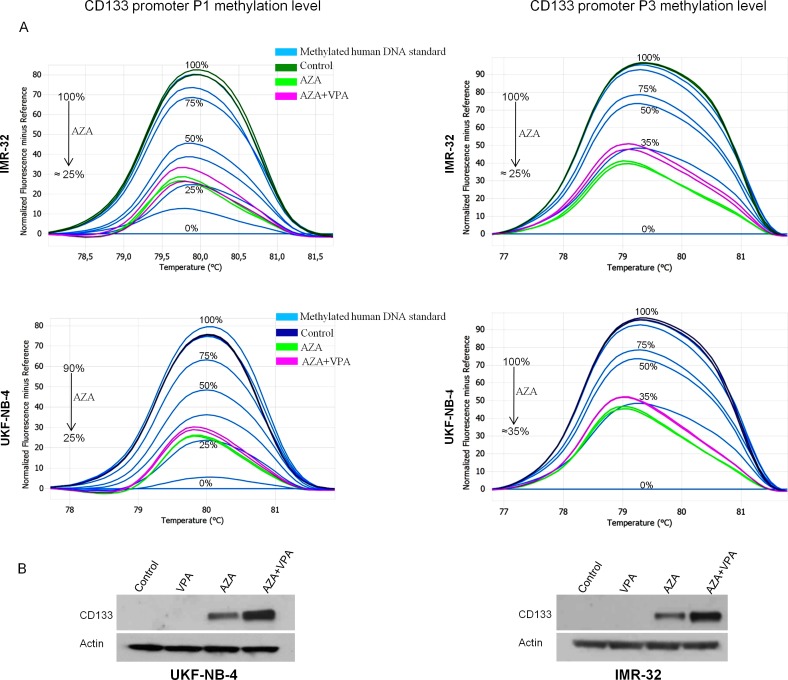
Normalized melt curves showing methylation status of promoters P1 and P3 in UKF-NB-4 and IMR-32 before and after using AZA and in combination with VPA.Western blot is showing the effect of 1mM VPA and AZA on CD133 expression in methylated cell lines. (A) Treatment with AZA decreased the methylation of both promoters P1 and P3 in UKF-NB-4 and IMR-32. (B) CD133 was not detected in cell lines with methylated promoters (UKF-NB-4, IMR-32). Re-expression of CD133 was in a small amount after applying AZA and in high amount when combined with VPA. VPA alone did not induce CD133 protein in UKF-NB-4 and IMR-32.